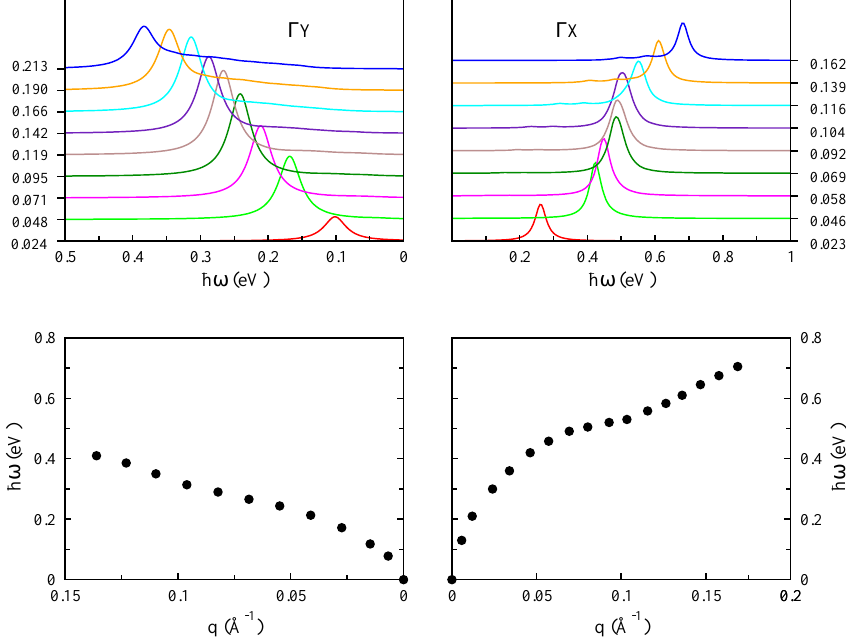
Figure 18. The electron-energy loss function of monolayer phosphorene for different values of q along the Γ X and Γ Y directions (upper panel). In the bottom panel, the plasmon modes corresponding to the peaks in the EEL function in the upper panel are plotted. In this case, the Fermi level is shifted up by 0.1 eV, corresponding to n = 3.9 × 10 13 cm − 2 .